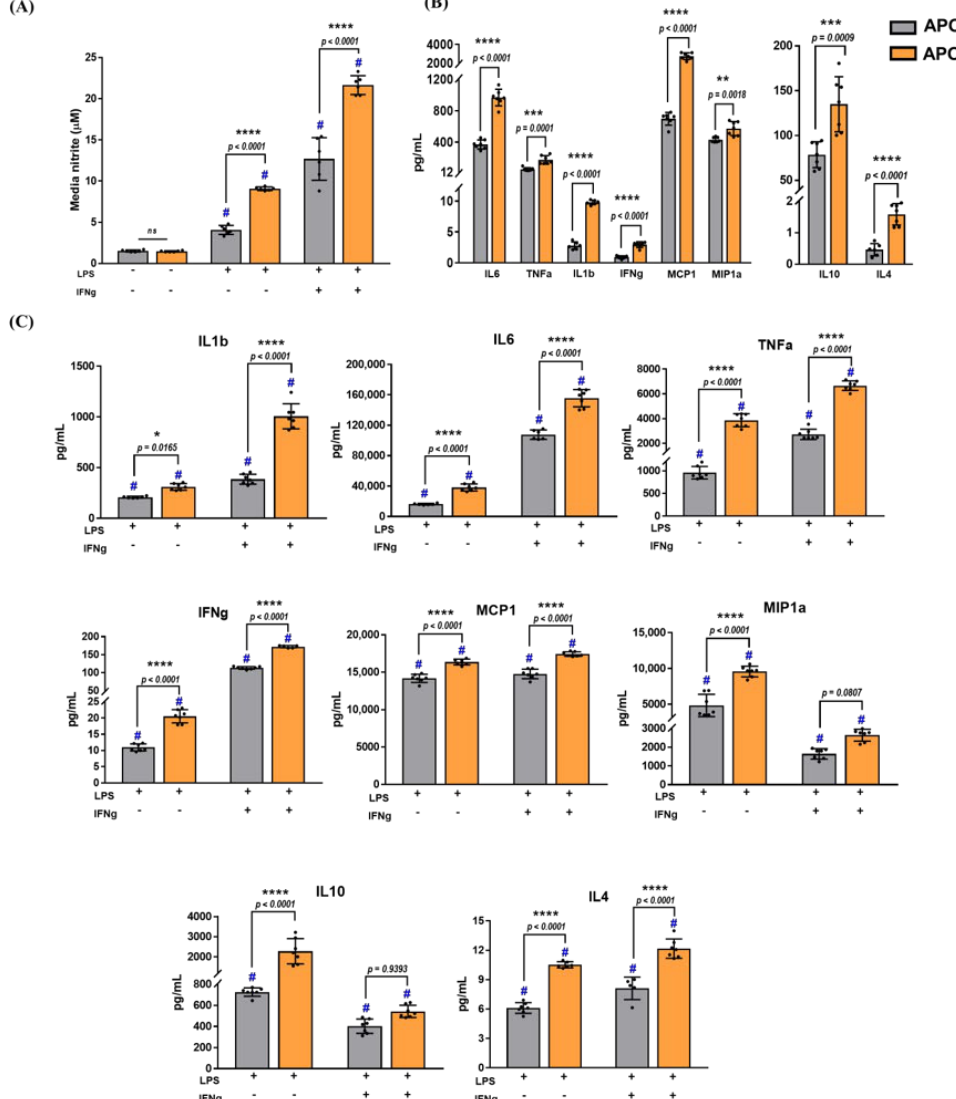
Figure 4. APOE4 genotype exacerbates release of pro − and anti − inflammatory cytokines: cytokine levels were measured following treatment with LPS or LPS + IFNg for 24 h. ( A ) Average levels of nitrite (±standard deviation) accumulated in the media were measured by GRIESS assay. Using two − way ANOVA, significant treatment and genotype effects were observed. # denotes a significant increase compared to the respective genotype control ( p < 0.05). ( B ) Basal levels of secreted cytokines were measured in non − stimulated microglia after 24 h by an MSD multiplex assay. Comparisons between genotypes were made using an unpaired Student’s t − test. ( C ) Cytokine levels in the media were measured after treatment with LPS or a combination of LPS and IFNg for 24 h. Two − way ANOVA was used to assess cytokine release in mixed − sex microglia from APOE3 and APOE4 genotypes (N = 3 − 4 isolations, n = 6 − 8 plates). Data are represented as the mean ±standard deviation, and each data point denotes the average of each experimental plate. # denotes a significant increase compared to the respective genotype control (data not included in the graphs, p < 0.05). *, **, ***, and **** indicate statistical significance for the comparison and denote p < 0.05, 0.01, 0.001, and 0.0001, respectively. ns = not statistically significant ( p >0.05).